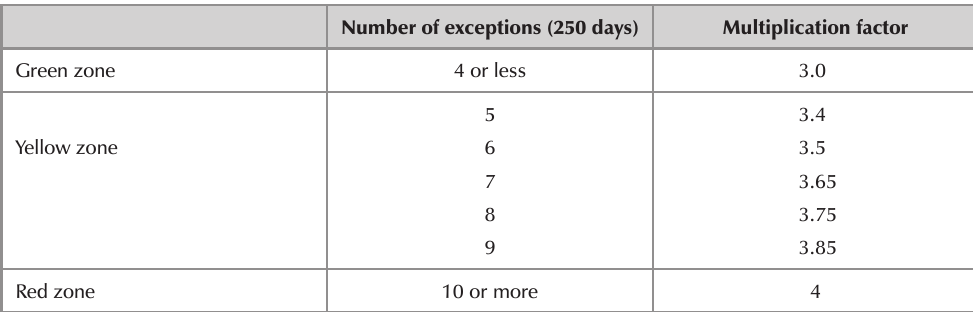
The Basel Committee’s three